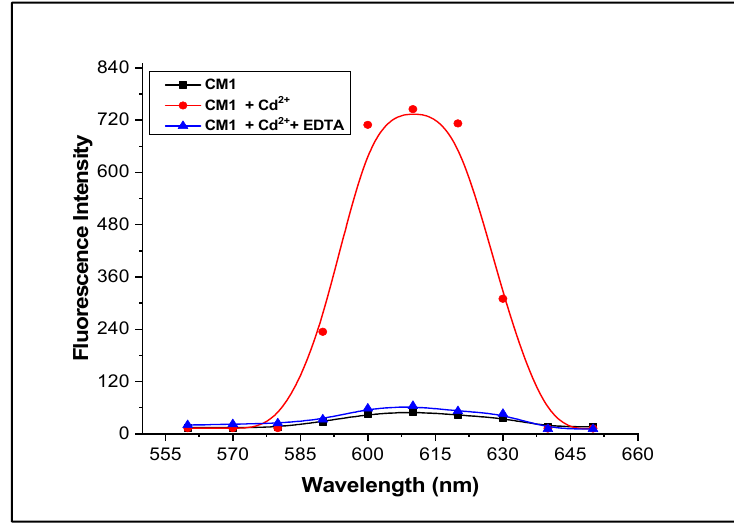
Figure 5. Reusablity study of CM1 (10 µM) with Cd 2+ (18 µM) and EDTA (18 µM) . Figure 5. Calibration curve from fluorescence titration of Cd 2+ (1–10 µ M) range and CM1 (10 µ M) at λ ex = 390 nm and λ em = 610